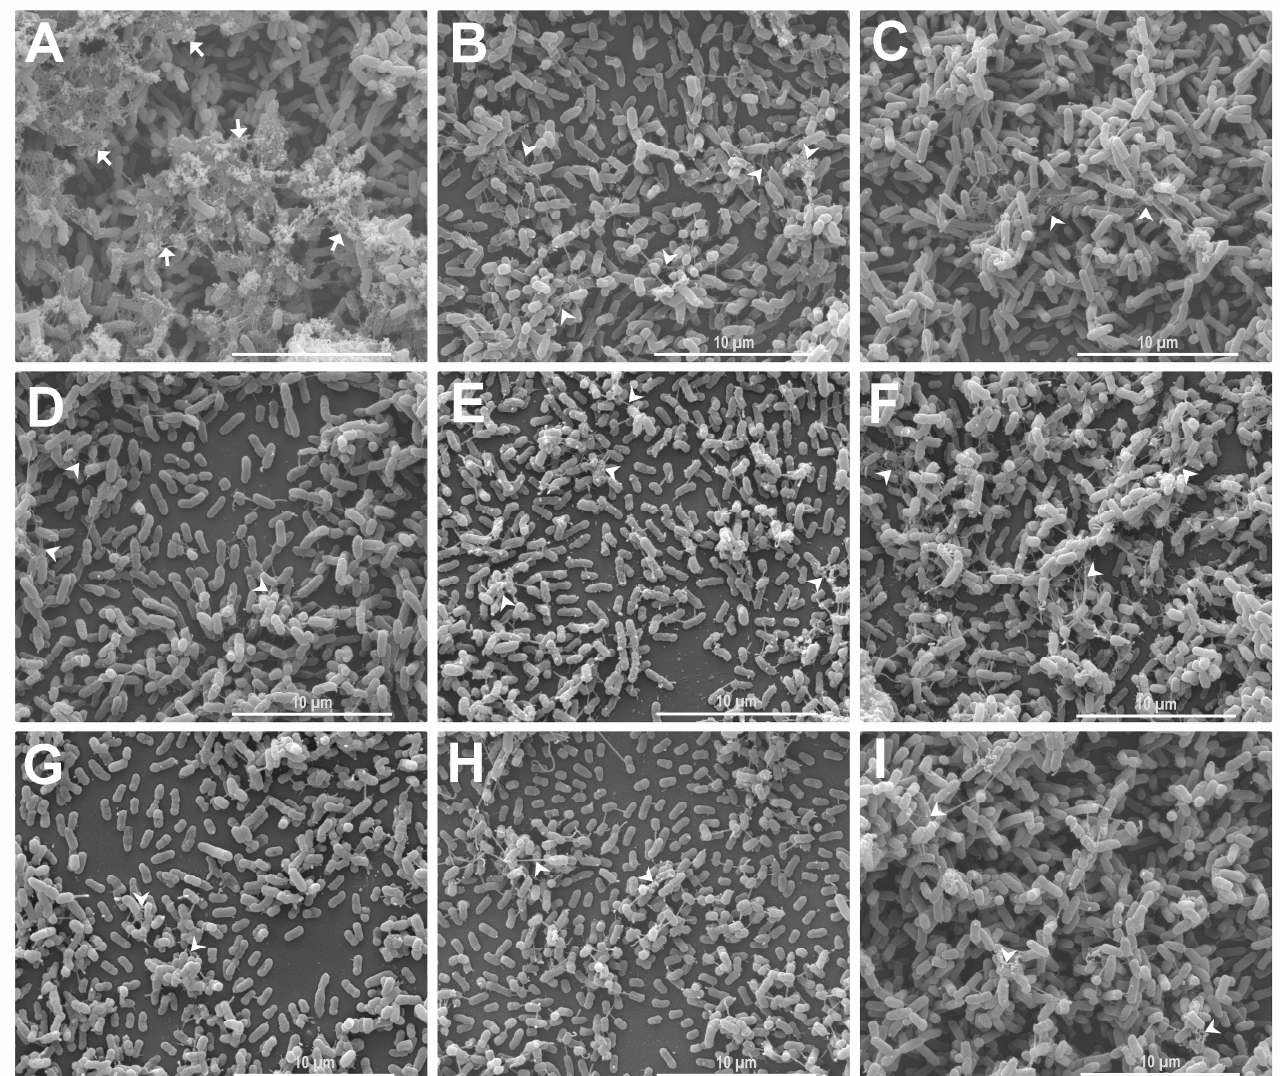
Figure 3. Scanning electron micrographs (magnification 10,000 × ) of the antibiofilm effect of oregano- derived antimicrobials and bioAgNP individually and in combination against enteroaggregative Escherichia coli (EAEC 042), showing biofilm structure. Preformed biofilms (24 h) in glass slides were exposed for 24 h to eight different treatments at subinhibitory concentrations. ( A ) Untreated control (bio fi lm at a later stage, 48 h of growth). ( B ) OEO at 0.3 mg/mL. ( C ) Car at 0.31 mg/mL. ( D ) Thy at 0.12 mg/mL. ( E ) bioAgNP at 7.88 µg/mL. ( F ) Combination of OEO (0.01 mg/mL) plus bioAgNP (3.94 µg/mL). ( G ) Combination of Car (0.15 mg/mL) plus bioAgNP (3.94 µg/mL). ( H ) Combination of Thy (0.06 mg/mL) plus bioAgNP (3.94 µg/mL). ( I ) Combination of Car (0.15 mg/mL) plus Thy (0.06 mg/mL). Micrographs ( A – I ) show the cell density and exopolysaccharide matrix of EAEC 042 in detail, including the unstructured matrix. Arrows: structured exopolysaccharide matrix with undamaged intercellular networks. Arrowheads: unstructured exopolysaccharide matrix with poor intercellular networks.